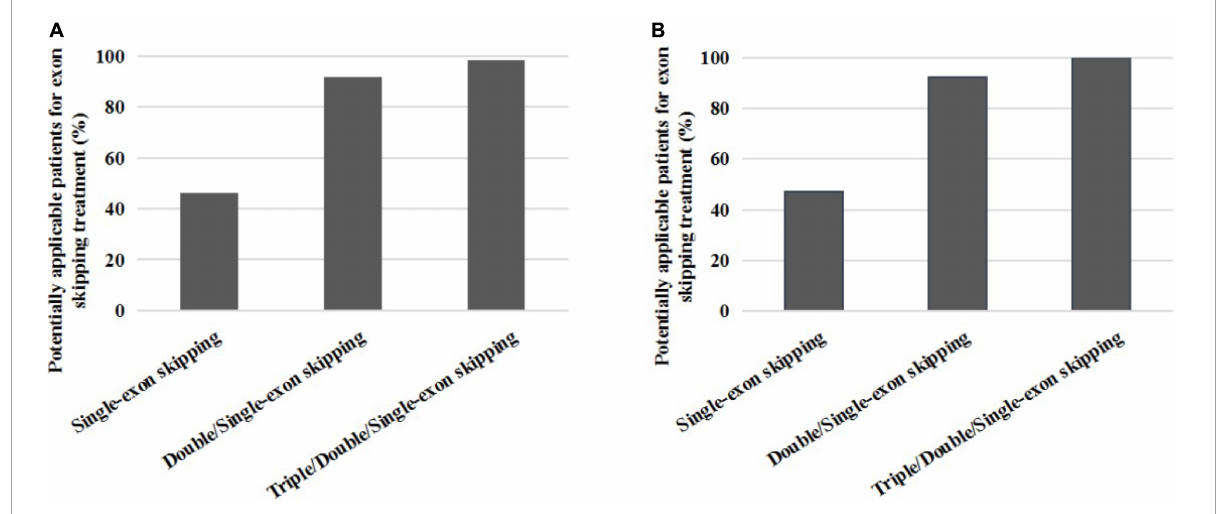
FIGURE3 The proportion distribution of potential small mutations single and multiple exons skipping treatments in all patients (A) and DMD/IMD (B) .